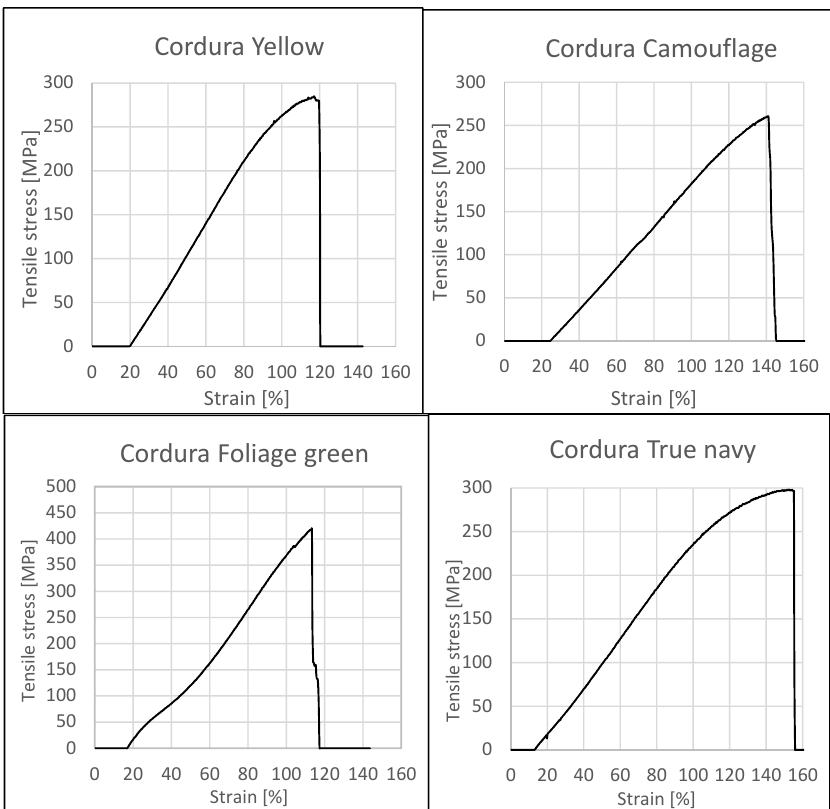
Figure 4. Stress–strain curve for the investigated composites.